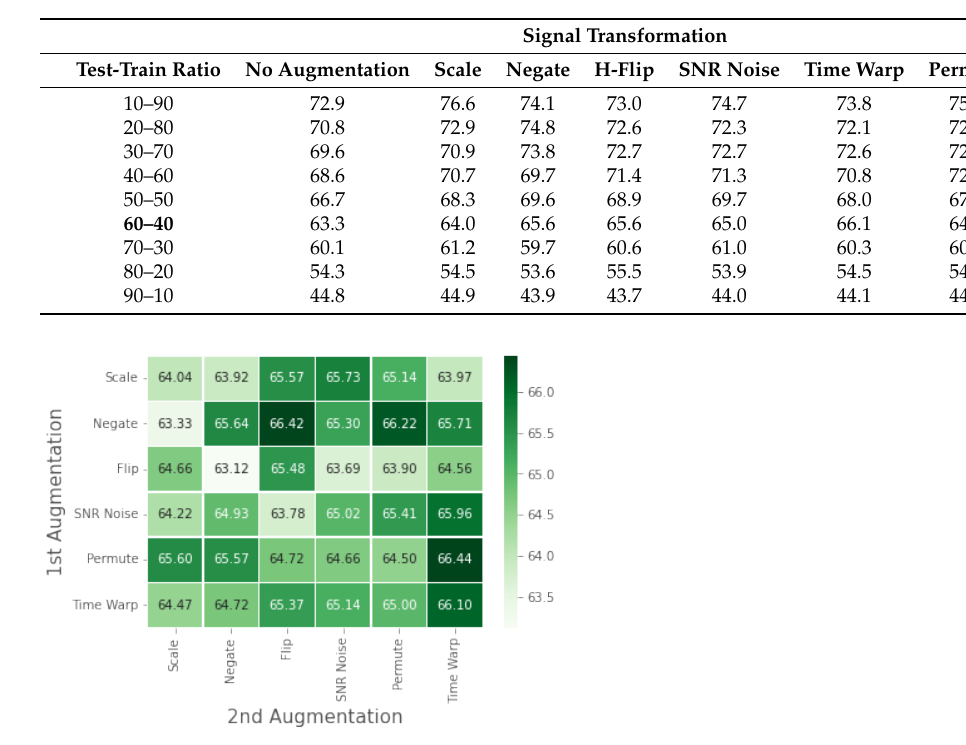
Table 4. Performance of the T d with varying test-train ratios was explored for each primary augmen- tation separately. This table presents the results obtained from the RML dataset.